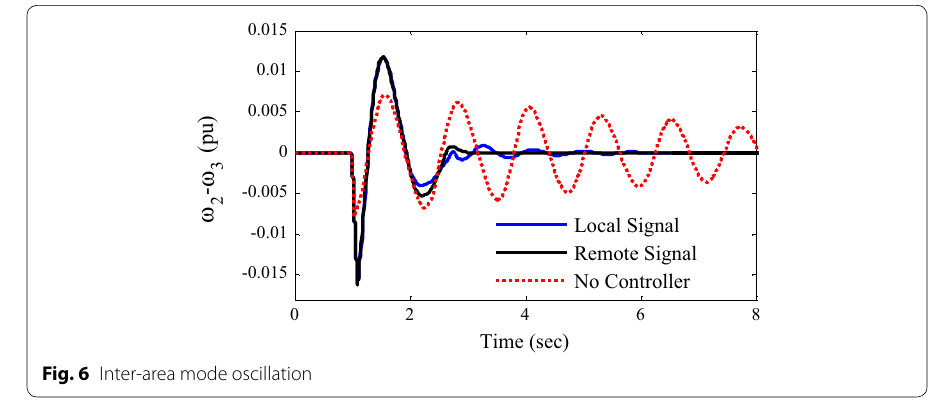
Fig. 6 Inter-area mode oscillation